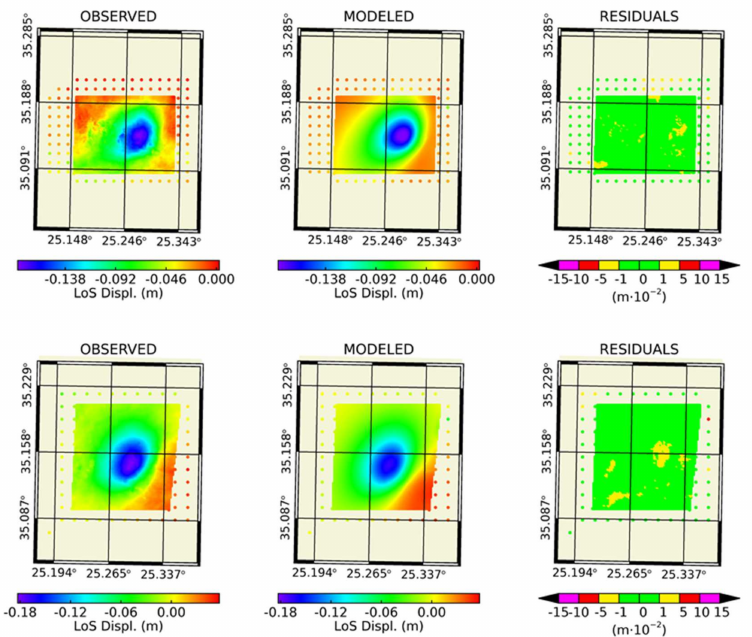
Figure 7. Comparison of LOS displacements from observed and modeled data for the 27 September 2021 earthquake using the ascending ( up ) and descending ( down )